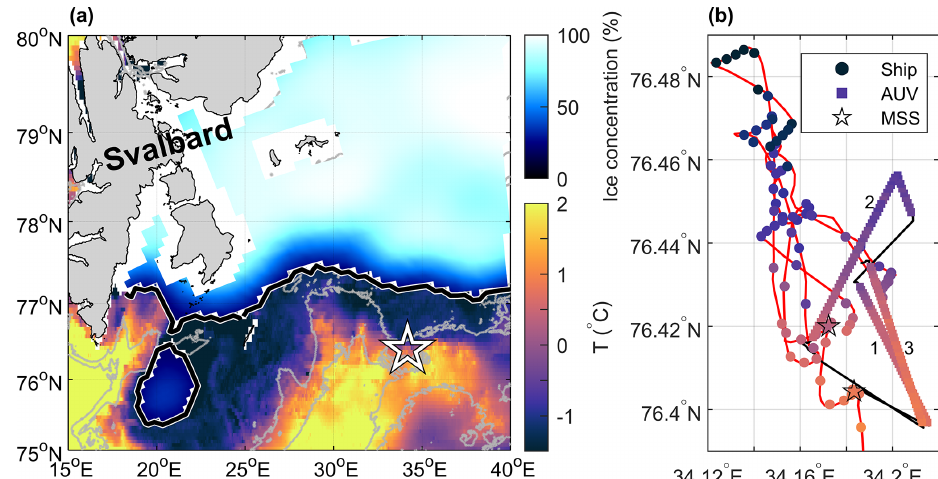
Figure 1. (a) Overview map of the study region in the Barents Sea. Ice concentration and ice edge (thick black contour) on 26 February 2021 are from OSI SAF (OSI SAF, 2017). Sea surface temperature is from the EU Copernicus Marine Service product SEAICE_ARC_SEAICE_L4_NRT_OBSERVATIONS_011_008 at 0.05 ◦ resolution based upon observations from the Metop-A AVHRR instrument. The experiment location marked by a star near 34 ◦ E is expanded in (b) . Gray isobaths are drawn at 200 and 300m depth using IBCAO-v4 (Jakobsson et al., 2020). (b) The ship’s track (red) with near-surface temperature from the ship’s thermosalinograph and the AUV track (black) with the AUV’s temperature measurements along the three transects are color-coded (temperature color scale is the same as in a ). Stations where a vertical microstructure profile (MSS) was collected are also